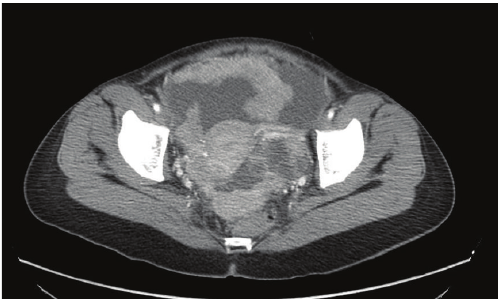
Figure 1: CT scan. Pelvic mass with ascites, peritoneal deposits, and enlargement of the greater omentum.